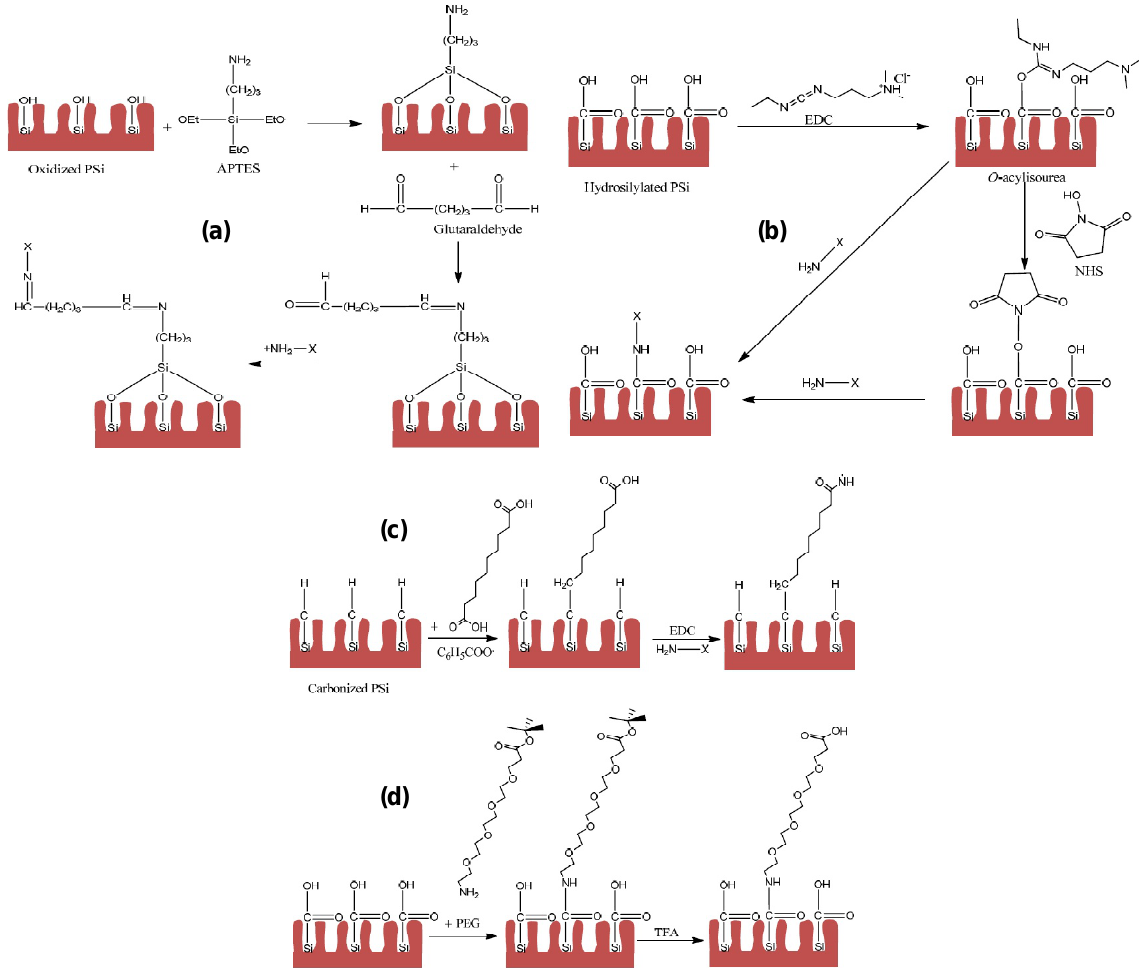
Fig. 7. Biofunctionalization of (a) oxidized PSi through APTES and glutaraldehyde chemistry, (b) hydrosilylated PSi through direct EDC and two-step EDC/NHS procedure, (c) carbonized PSi through sebacic acid fol- lowed by EDC chemistry, and (d) hydrosilylated PSi via attachment of PEG to improve biocompatibility. The reagent TFA is trifluoroacetic acid. The ‘X’ can be DNA, protein, or antibody, which attaches on the functionalized PSi through its amino